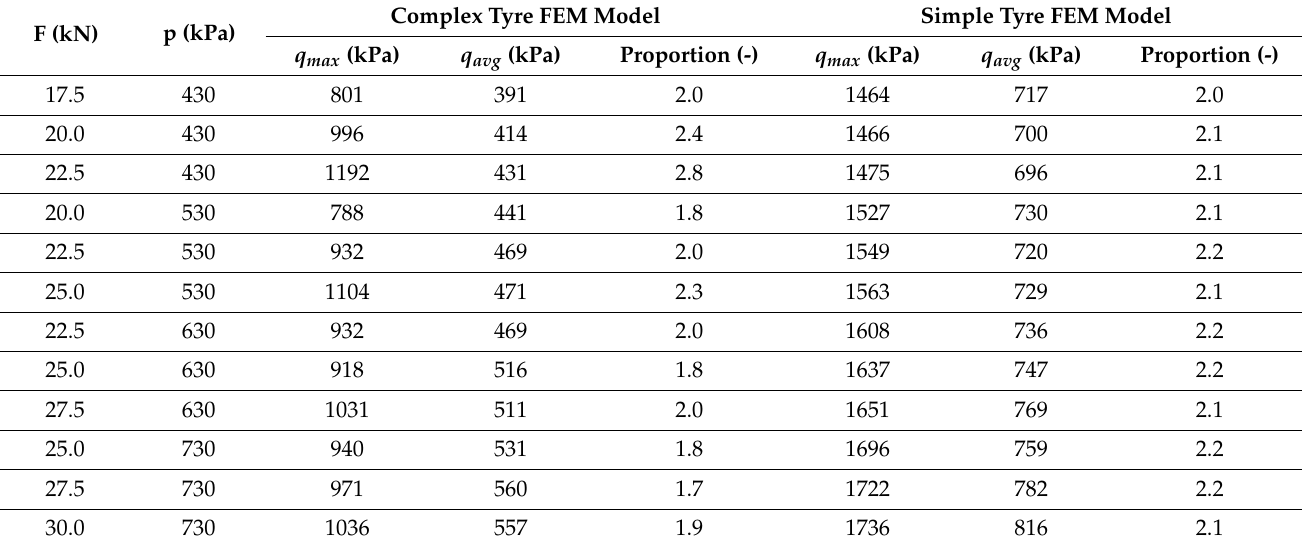
Table 8. Results of the tyre–pavement interaction